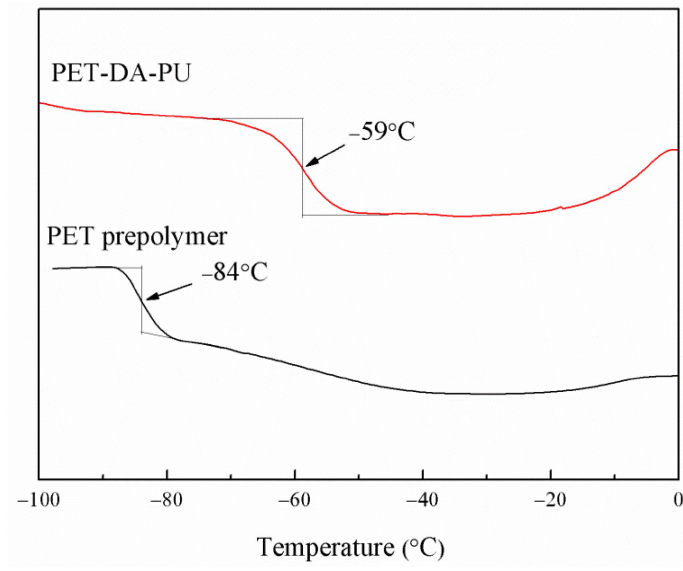
Figure 3. DSC curves of PET-DA-PU and PET prepolymer.